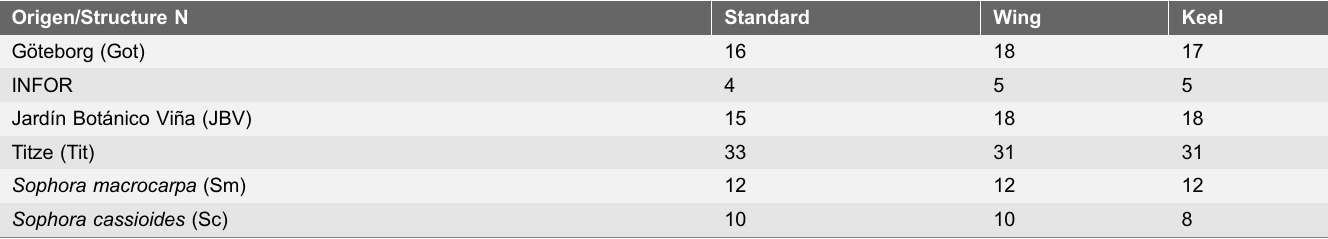
Table 1. Number of floral structures classified by